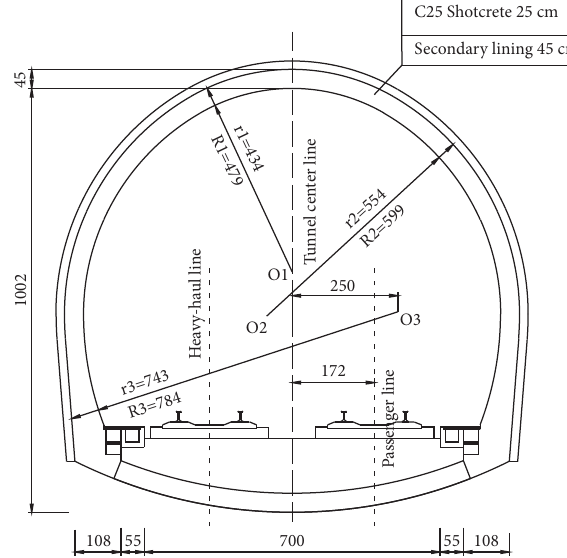
Figure 2: Design lining sectional drawing of class V surrounding rock. Figure